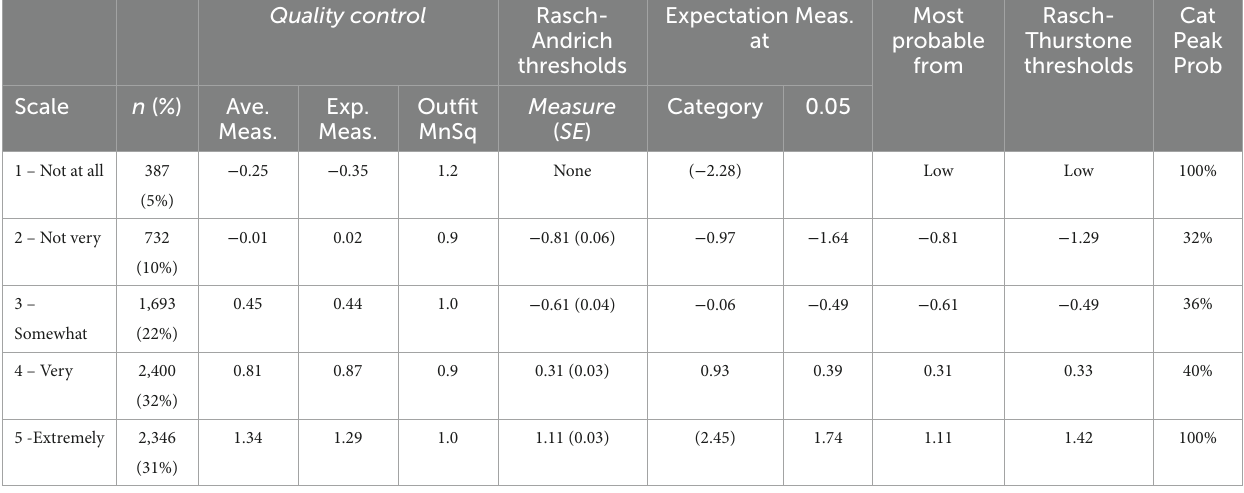
TABLE 2 MFRM analysis of criteria rating scale.